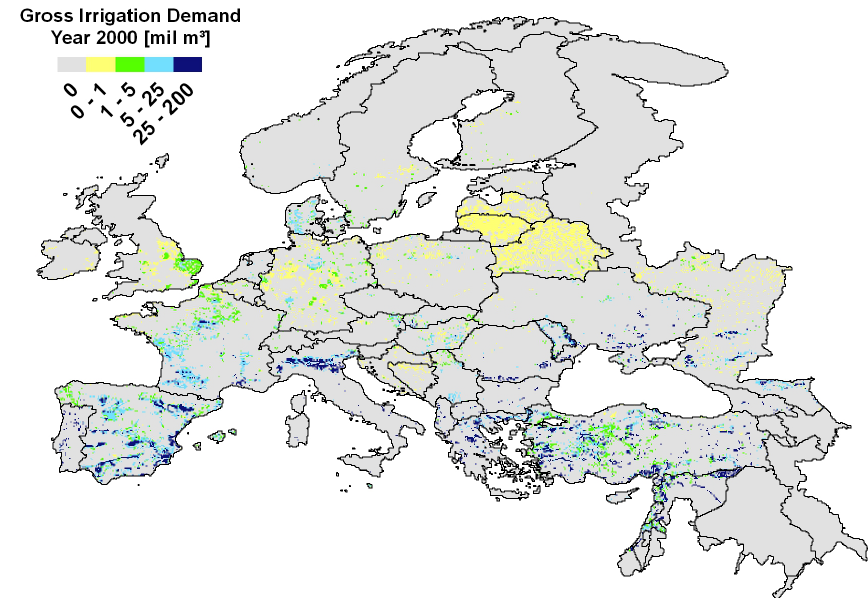
Figure 2: Gross irrigation water requirements for the year 2000, as modelled with Fig. 2. Gross irrigation water requirements for the year 2000, as modelled with LPJml.